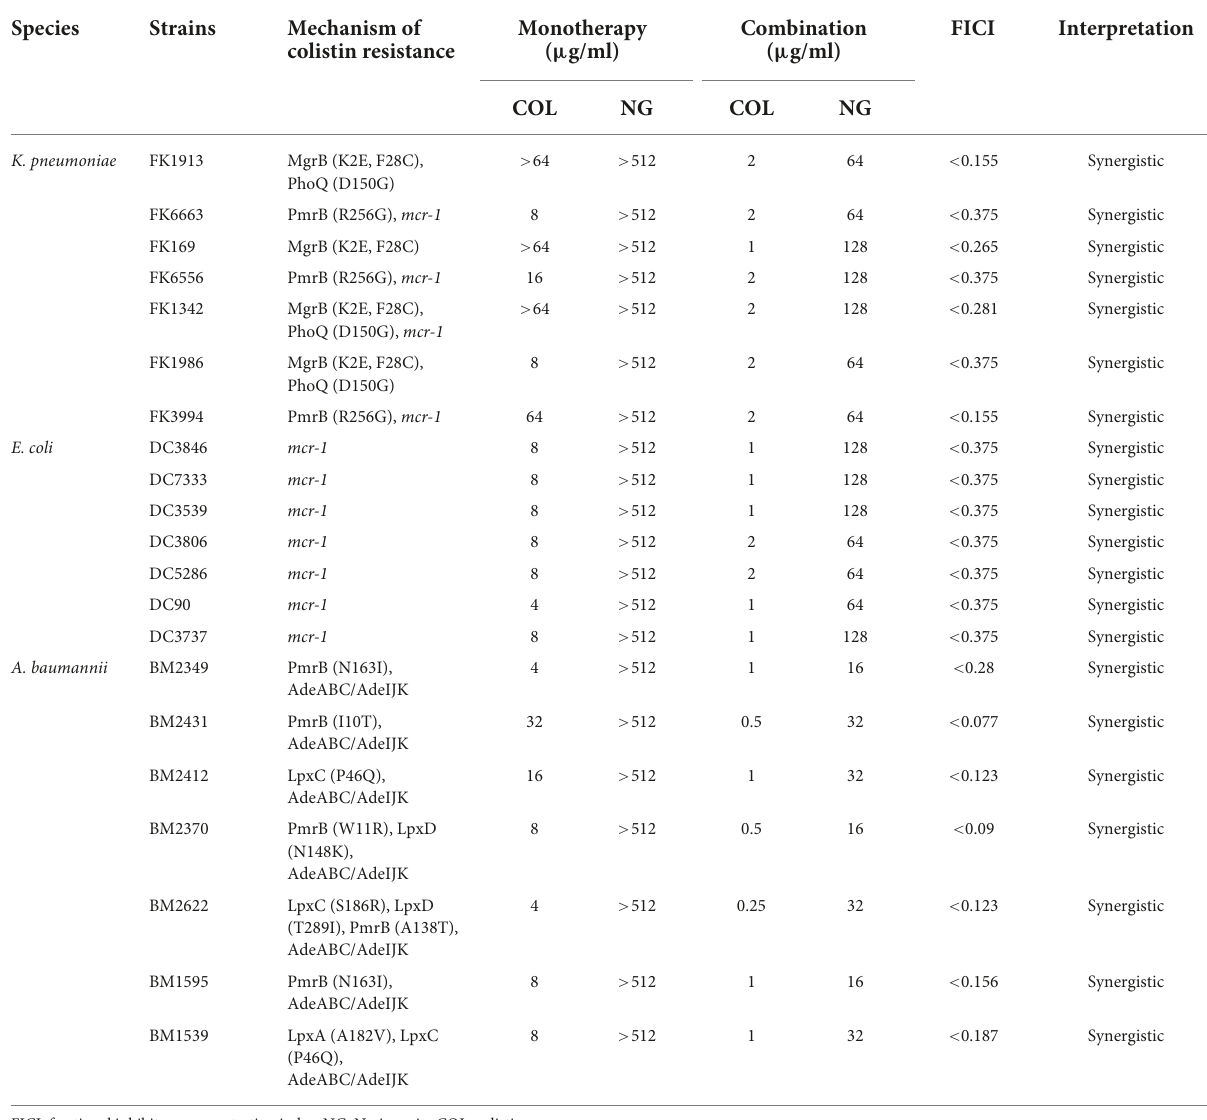
TABLE 2 Combination activities of NG with colistin.